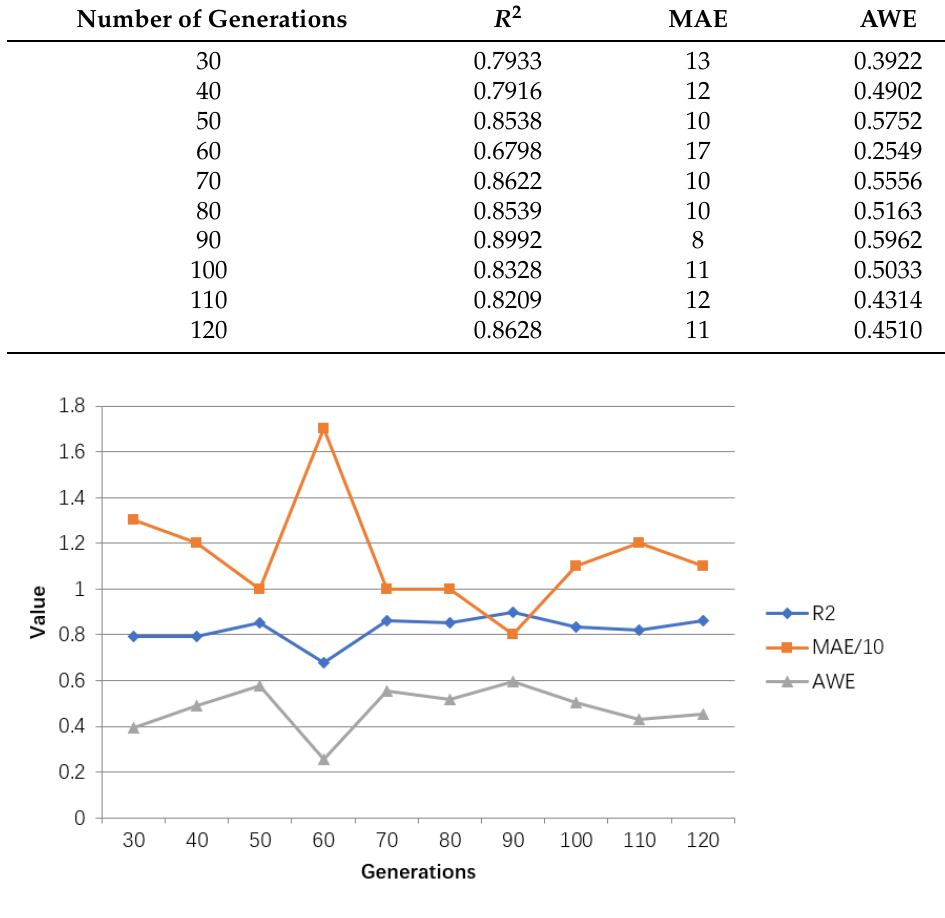
Figure 13. Line chart of adjustment results of hyperparameters in GA-BP model. The value represents results for R2, MAE/10, AWE for different parameters settings.